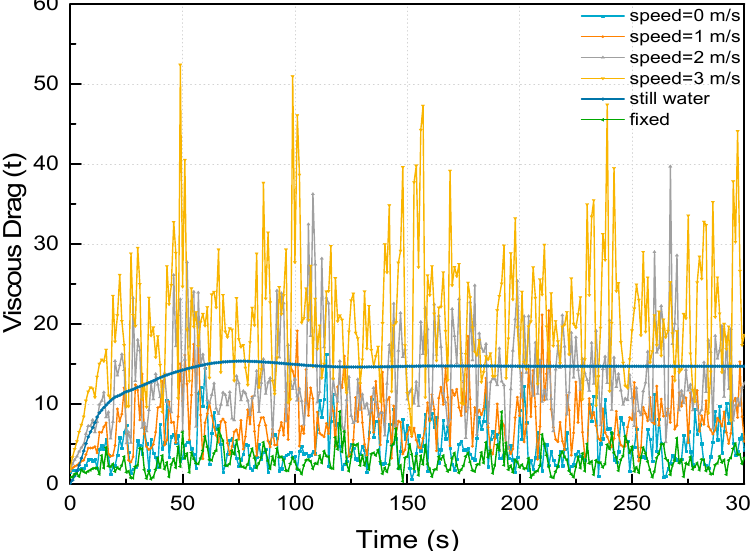
Figure 5. Comparison between the time history curves of the viscous drag force under different towing speeds for surface towing. speeds for surface